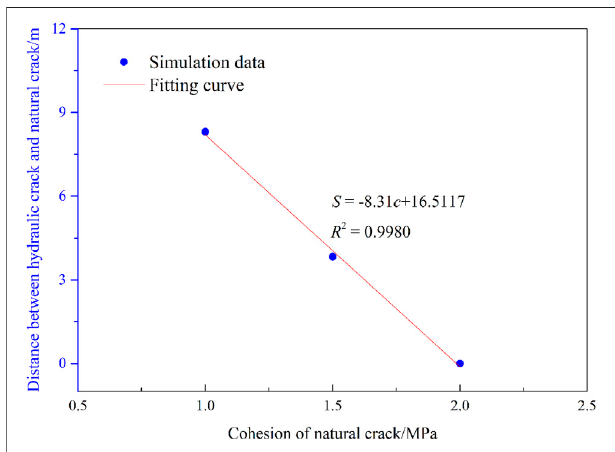
FIGURE12| TherelationshipbetweenthedistancefromtheHFtiptoNF and the cohesive of NF during the NF initiation.